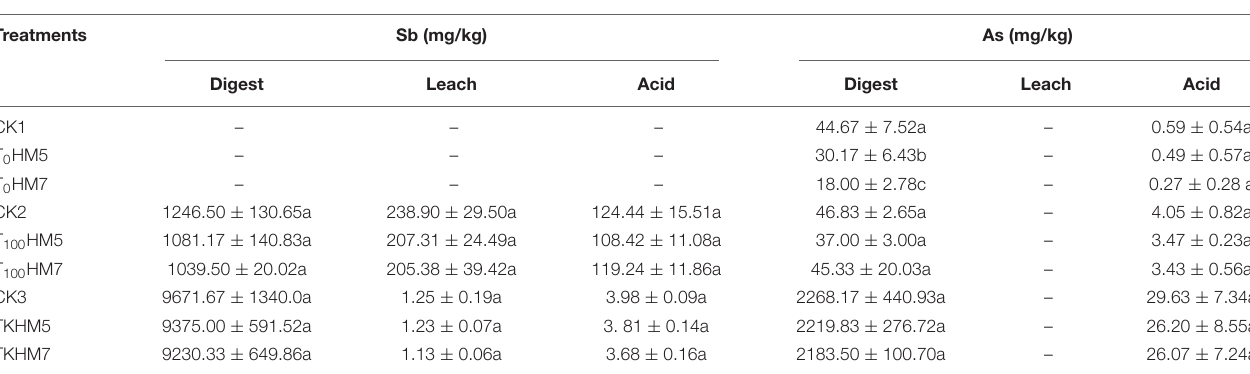
TABLE 2 | Different forms of Sb and As contents of treated soil and slag.